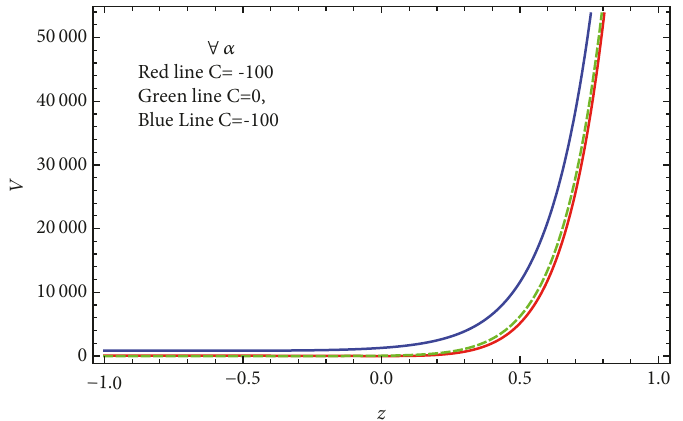
Figure 3: Potential versus redshift